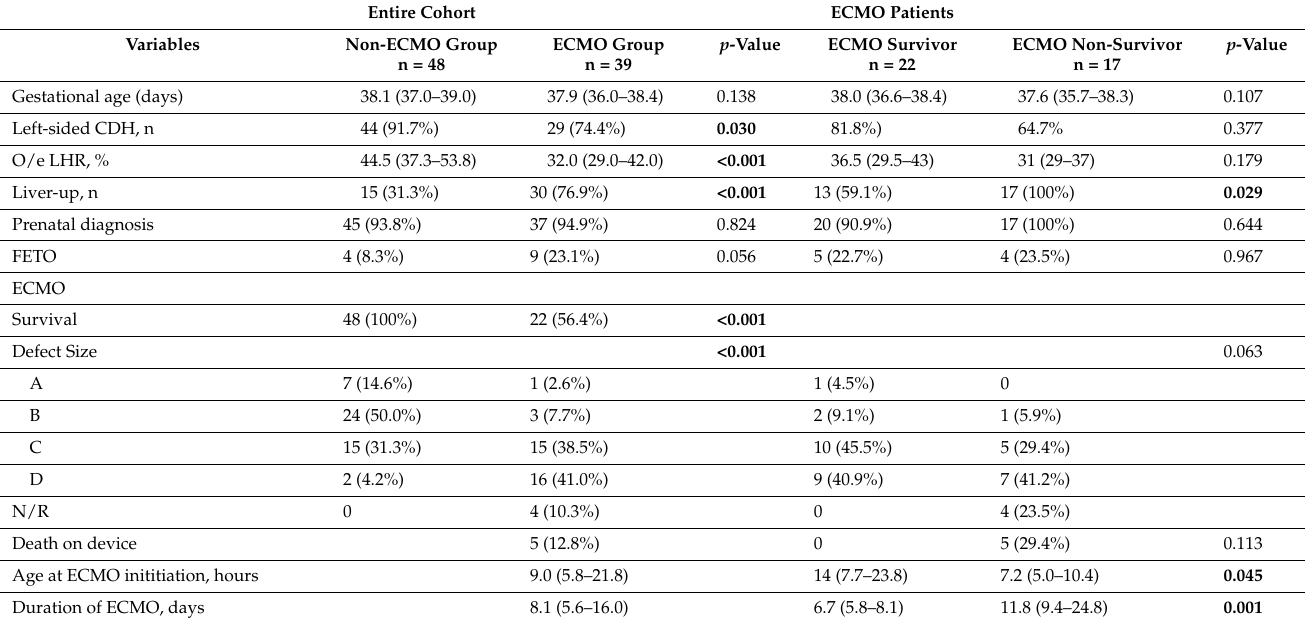
Table 1. Baseline characteristics according to group allocation. p -values below 0.05 are highlighted in bold. CDH, congenital diaphragmatic hernia; ECMO, extracorporeal membrane oxygenation; o/e LHR, observed-to-expected